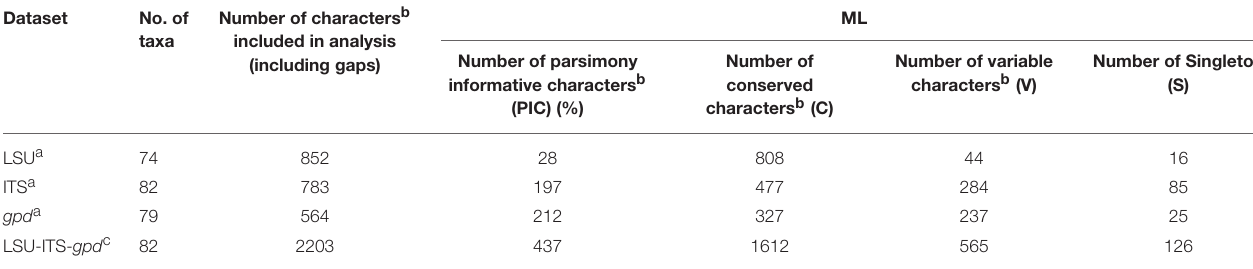
TABLE 3 | Statistics resulting from phylogenetic analyses of ITS, LSU, and gpd . Dataset